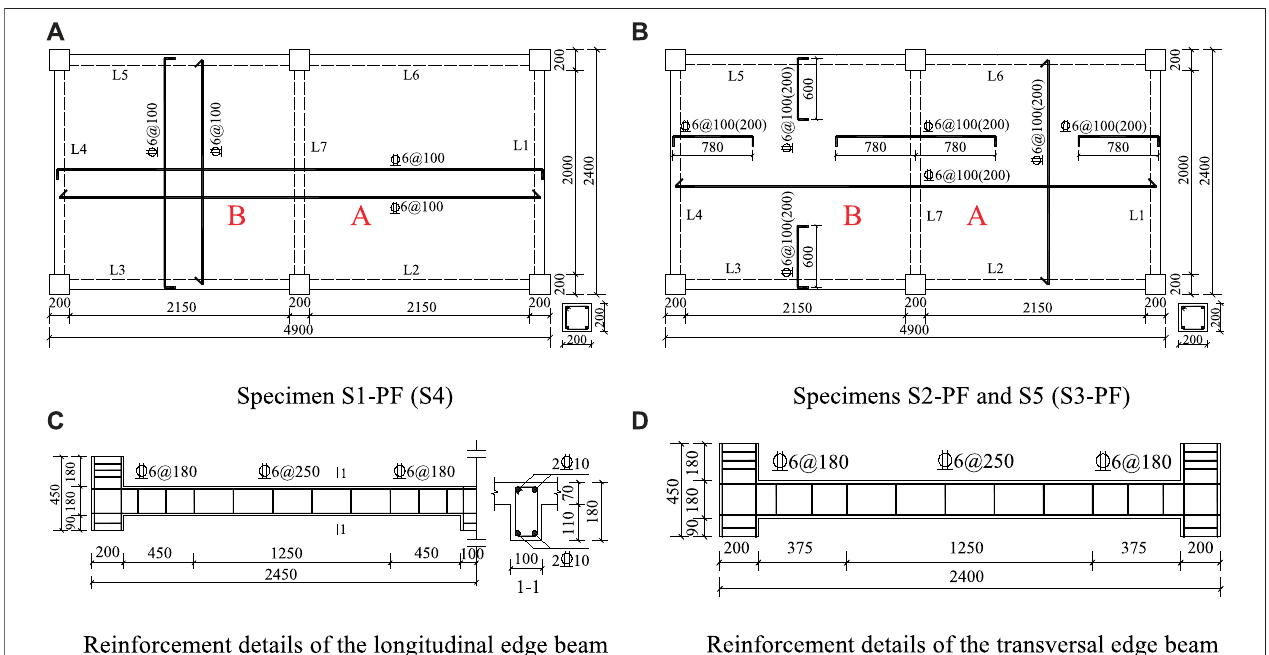
FIGURE 1 | Details of steel reinforcement layouts in the fi ve specimens (all dimensions in mm). (A) Specimen S1-PF (S4) (B) Specimens S2-PF and S5 (S3-PF) (C) Reinforcement details of the longitudinal edge beam (D) Reinforcement details of the transversal edge beam.